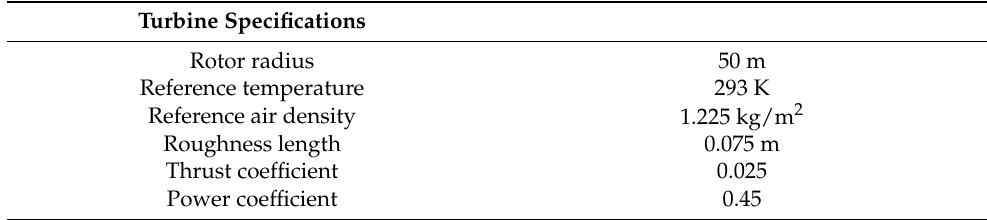
Table 1. Detailed specifications of the wind turbines.